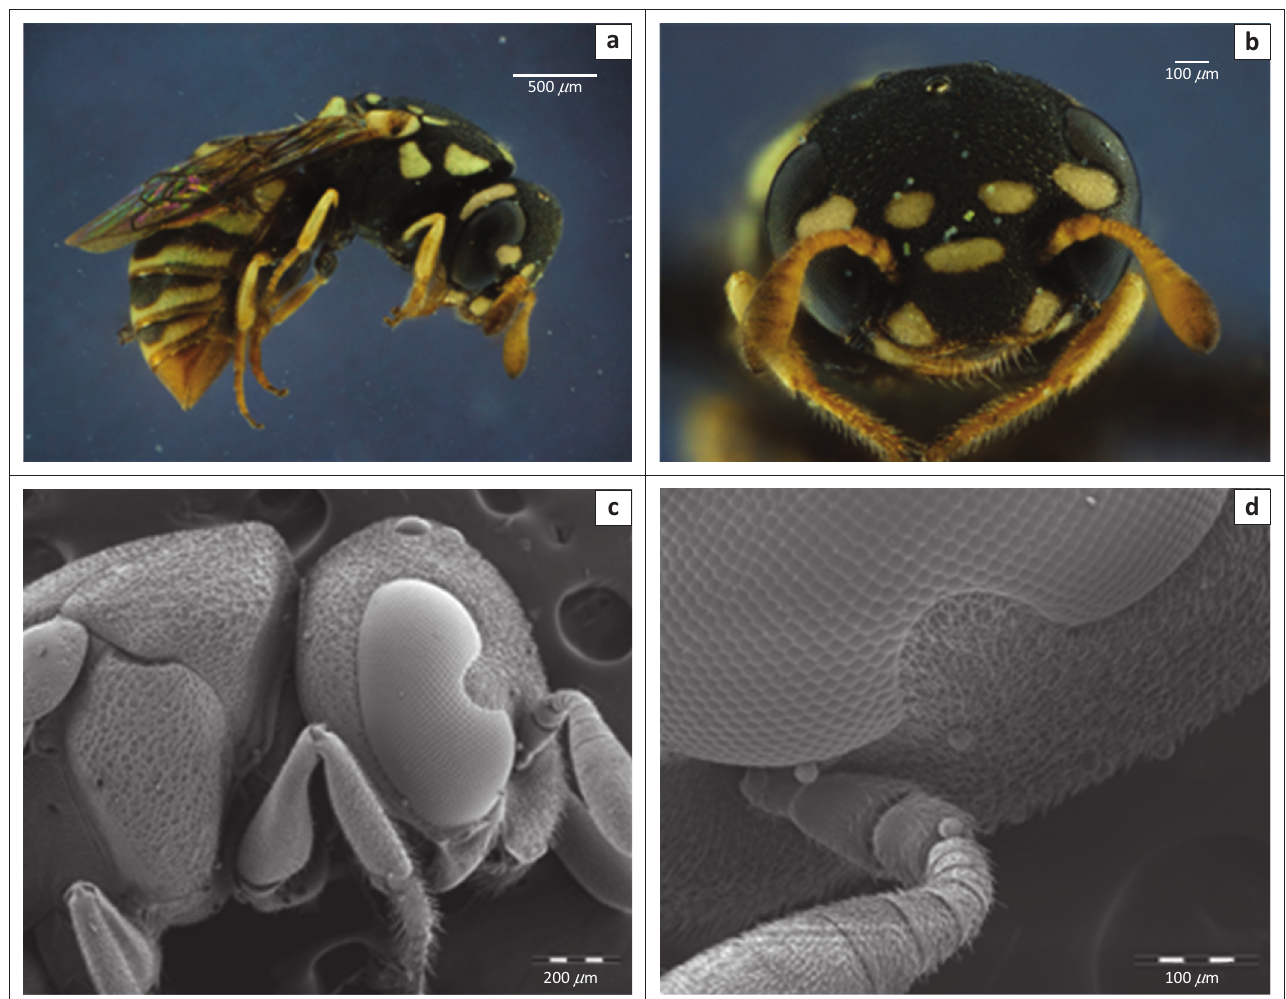
FIGURE 6: (a, b) Stereomicrographs of Quartinia sp. (Vespidae) . Scanning electron micrographs of several Frithia humilis pollen grains on the body (c) and the head and antenna